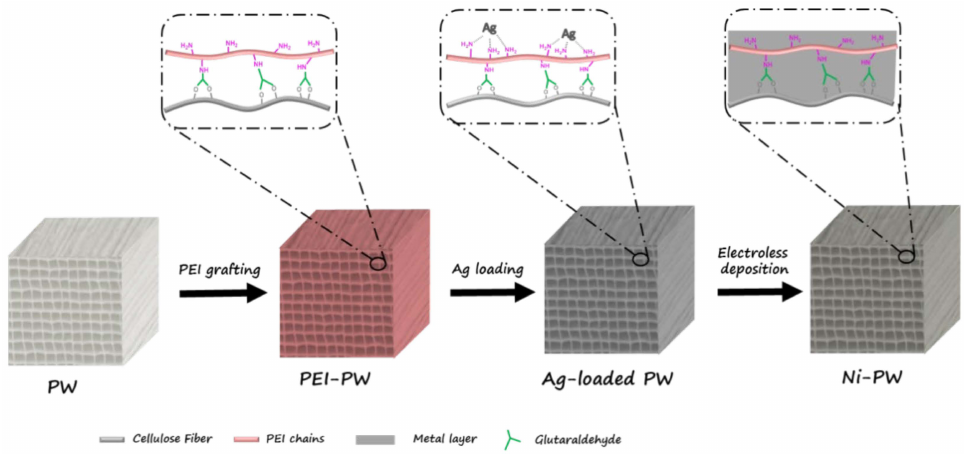
Figure 1. Schematic illustration of the PAMD strategy for the synthesis of the Ni-coated